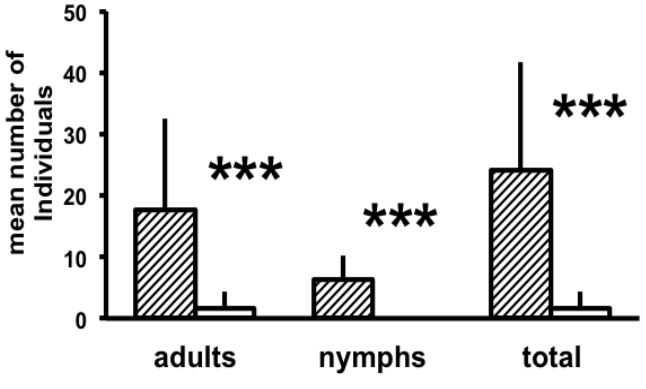
Figure 5. Mean number of adults, nymphs, and total (+S.D., n = 9) of D. pteronyssinus in test (shaded bars) and control Petri dishes (white bars) of a long range olfactometer after 48 h. The test Petri dish was baited with neryl propionate. *** p < 0.001 (Whitney-Mann